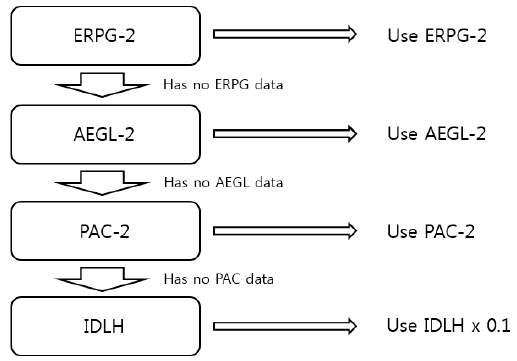
Figure 1. Endpoint concentration criteria.